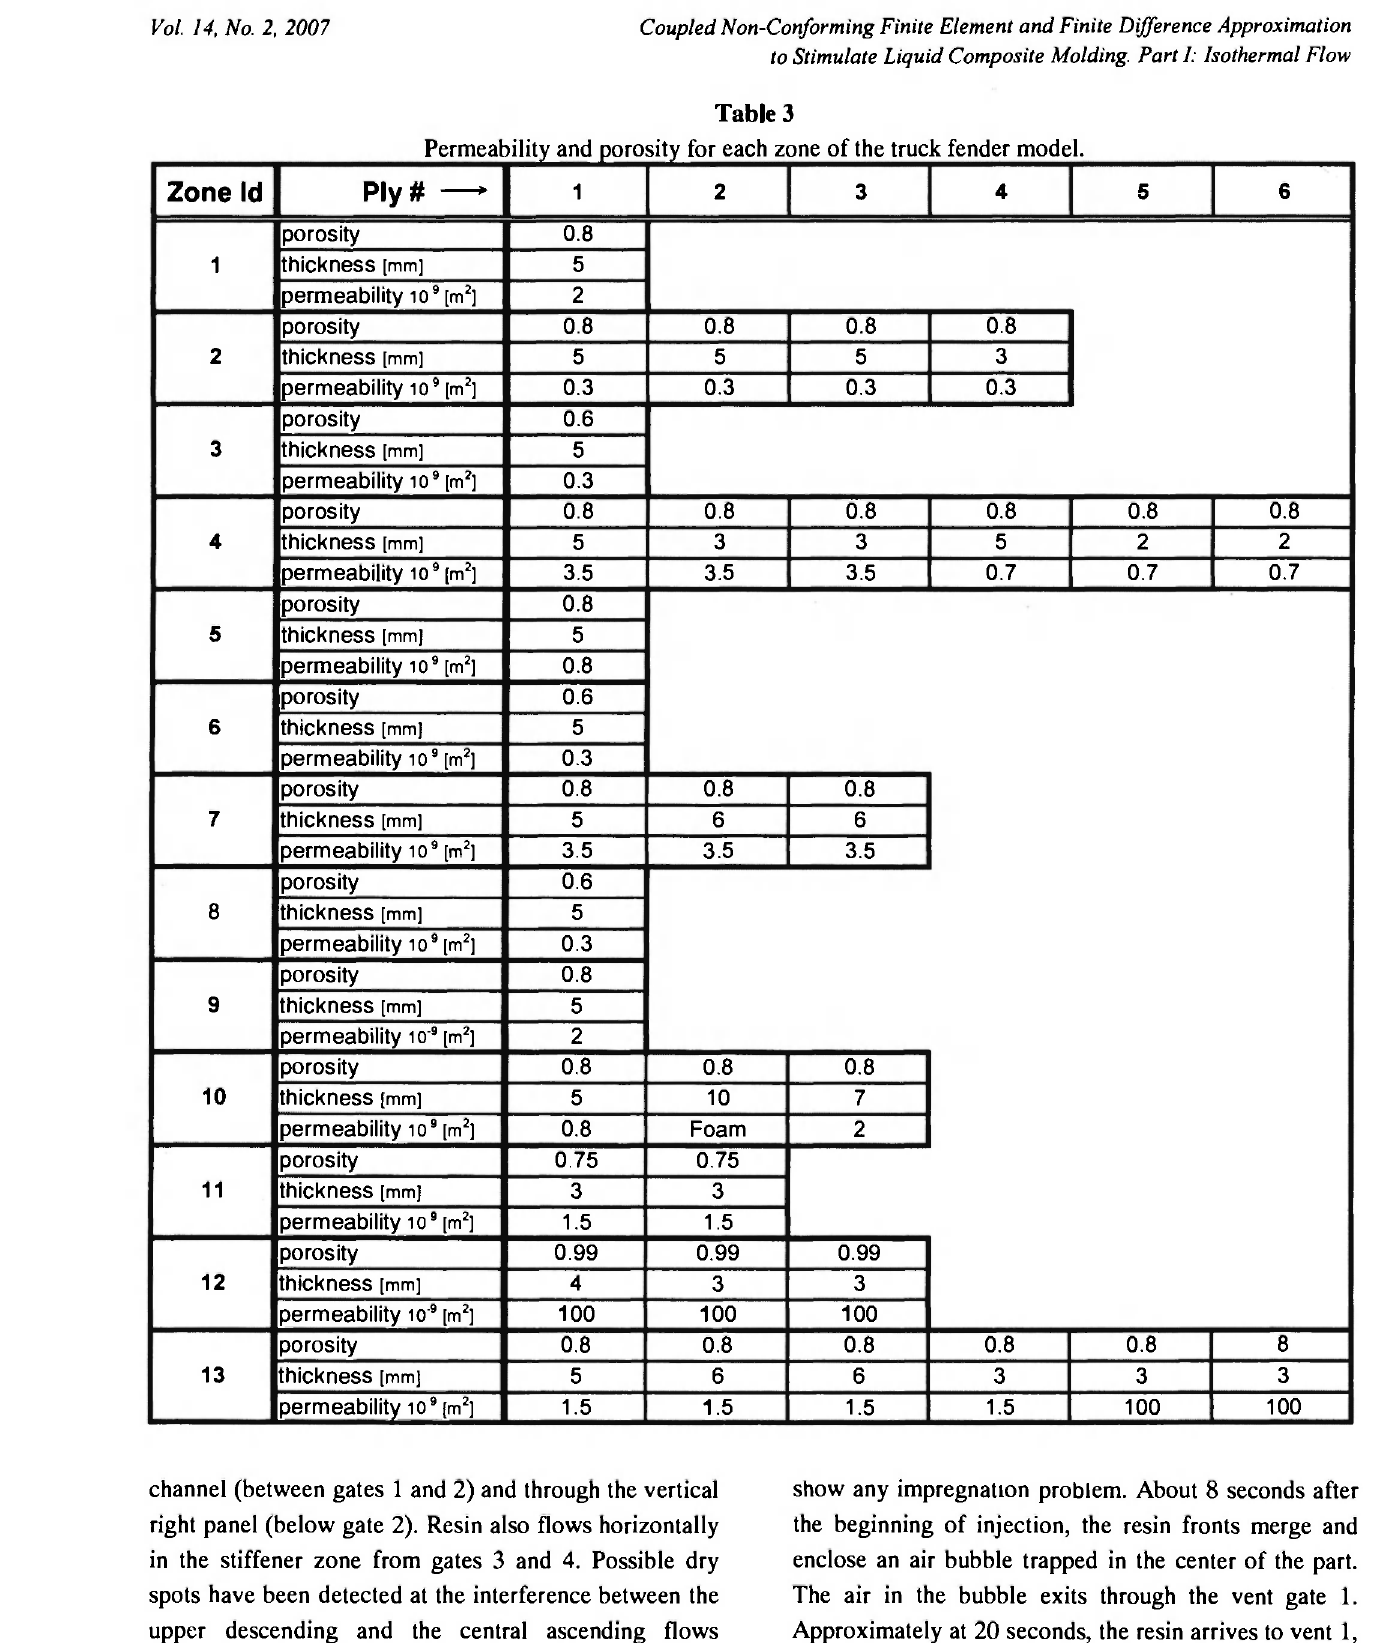
Permeability and porosity for each zone of the truck fender